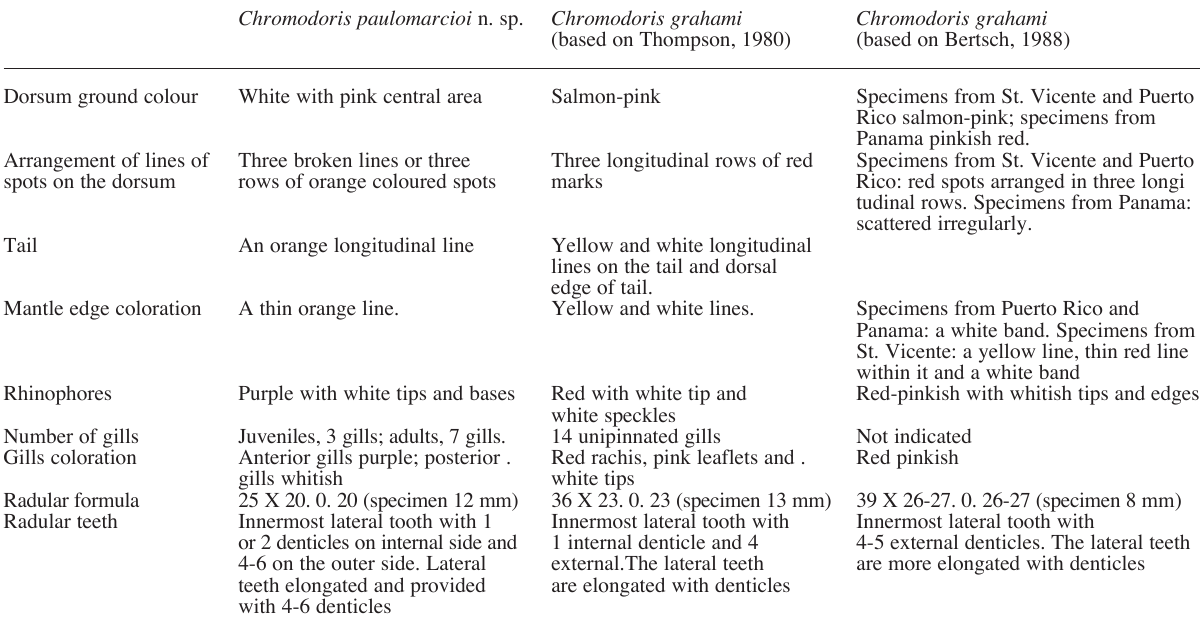
Specimens from St. Vicente and Puerto tudinal rows. Specimens from Panama: scattered irregularly. lines on the tail and dorsal edge of tail.